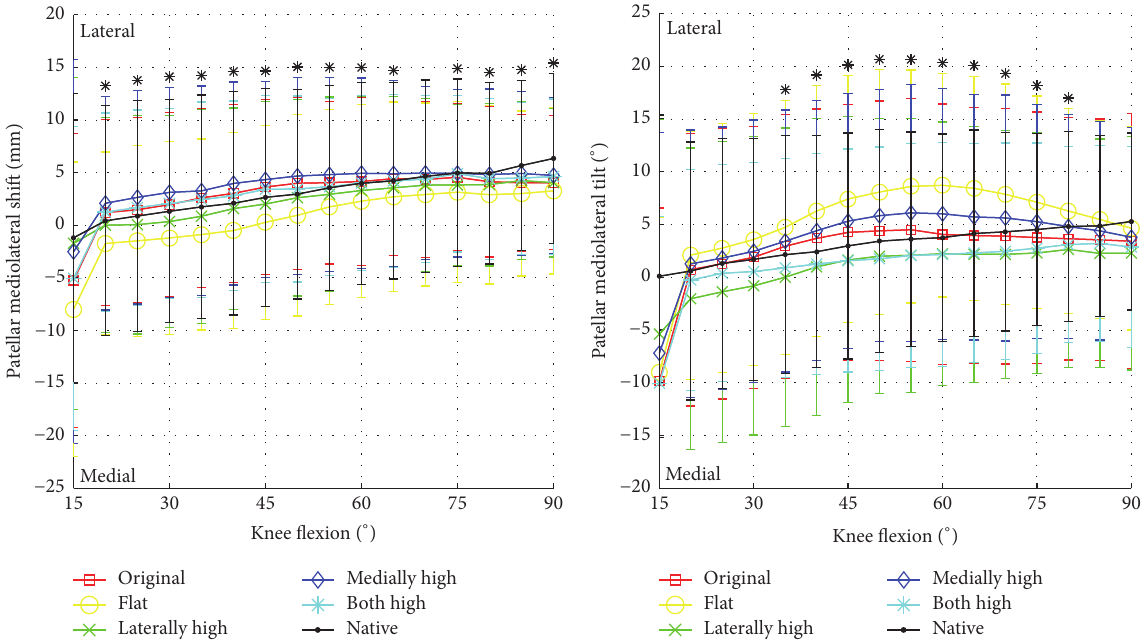
Figure 4: Patellofemoral kinematics with central muscle load after implantation of the different designs without patellar resurfacing (native, original, flat, laterally high, medially high, and both sides high) ( ∗ significant difference in